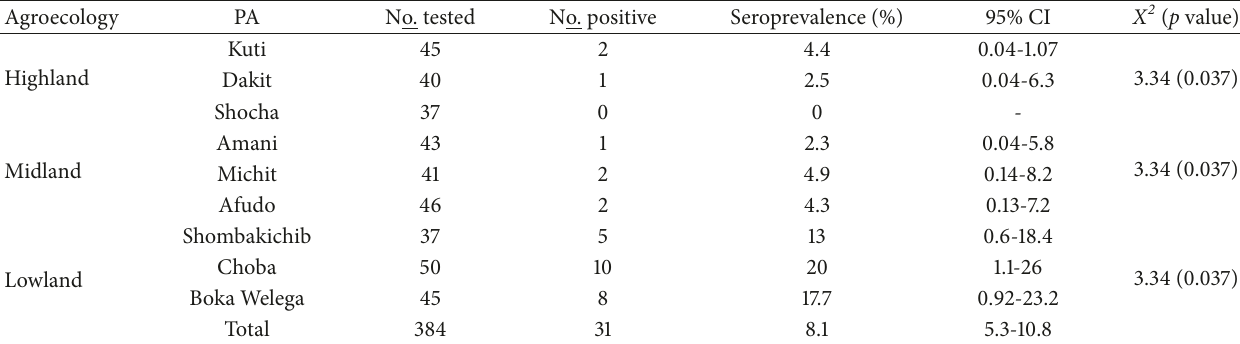
Table 1: Seroprevalence of CBPP based on altitude tested by X 2 .